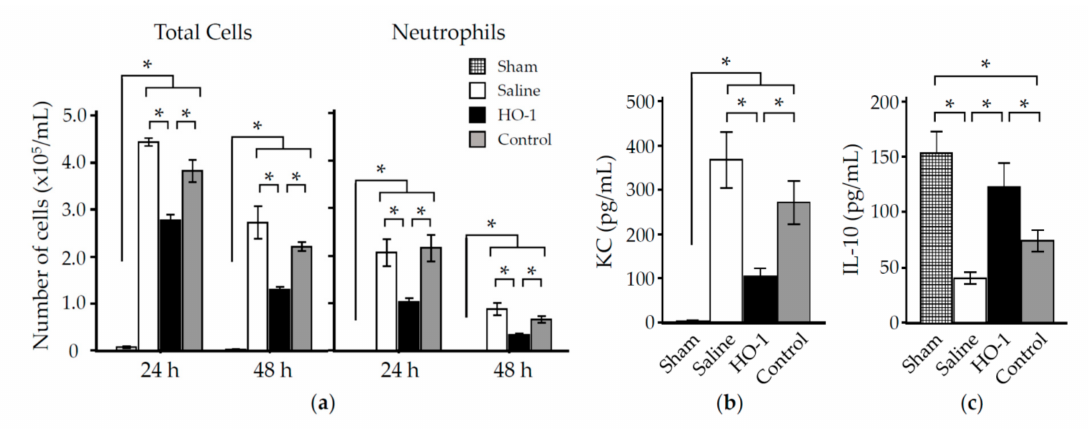
Figure 6. E ff ect of nasal administration of HO-1 lactis on lung inflammation in PPE-instilled emphysema mice. Mice were treated as described in Figure 5. ( a ) Total cells and neutrophils in bronchoalveolar lavage (BAL) fluid 24 and 48 h after PPE instillation. The concentrations of KC ( b ) and IL-10 ( c ) in BAL fluid were determined by ELISA. Results represent the mean ± SE of 2 to 3 independent experiments involving a total 5 to 10 mice / group. *, p < 0.05.